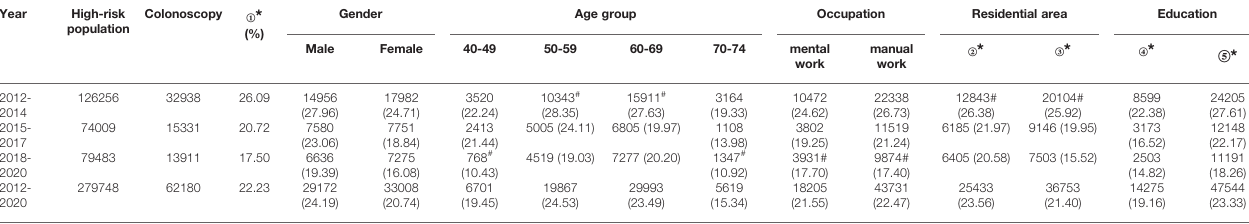
Age group Occupation Residential area